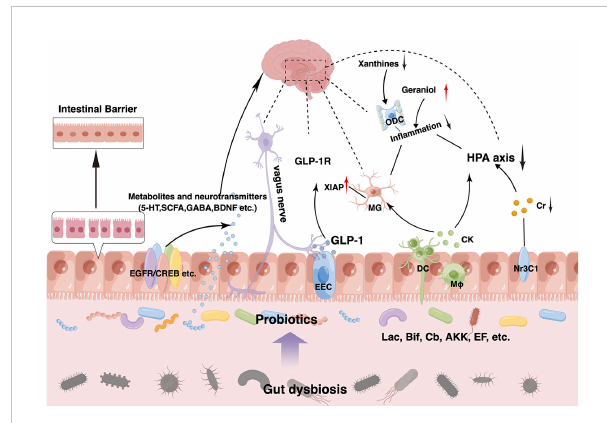
FIGURE 2 Therapeutic effects of probiotics on depression and its comorbidities. Probiotics exert antidepressant effects at multiple targets. Supplementation of probiotics can increase bene fi cial microorganisms and reduce harmful ones to achieve new gut eubiosis. Meanwhile, they can produce bene fi cial substances such as 5-hydroxytryptamine (5-HT), short-chain fatty acids (SCFAs) and brain-derived neurotrophic factor (BDNF) and so on by